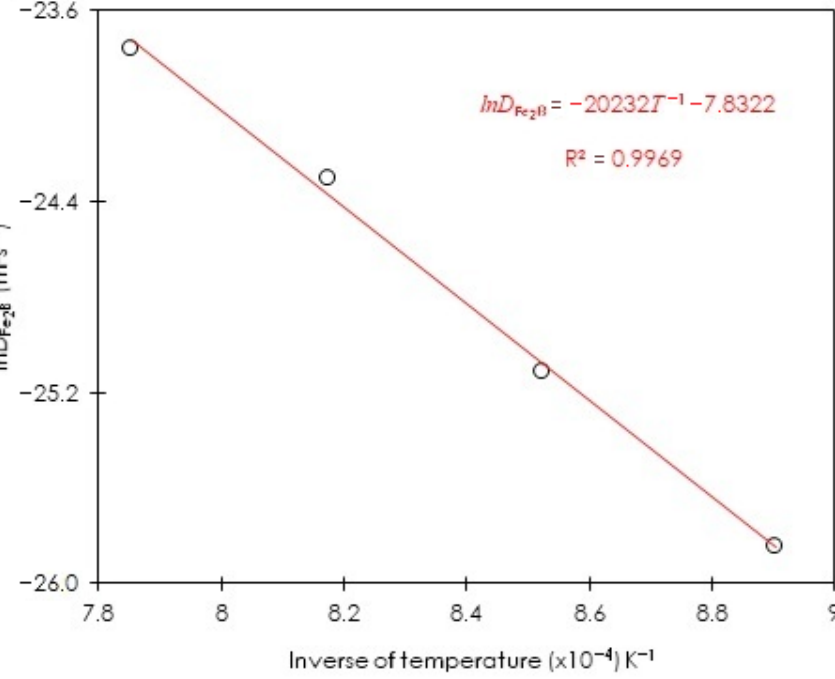
Figure 14. The plot of the square of Fe 2 B layer thickness versus exposure time. In Figure 15, the plot of the natural logarithm of estimated boron diffusivities in Fe 2 B is shown using the first approach (steady-state diffusion model) employing Equations (6) and (7) versus the inverse of process temperature.